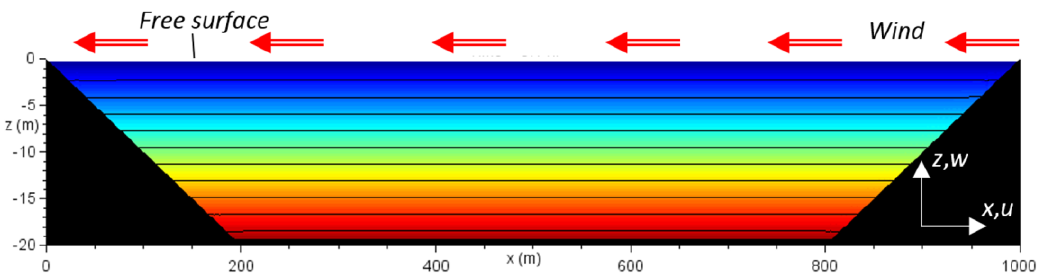
Figure 3. Model domain used in this study. Color shading denotes the initial concentration of an Eulerian concentration field. The prescribed wind stress is spatially uniform. See text for more details.